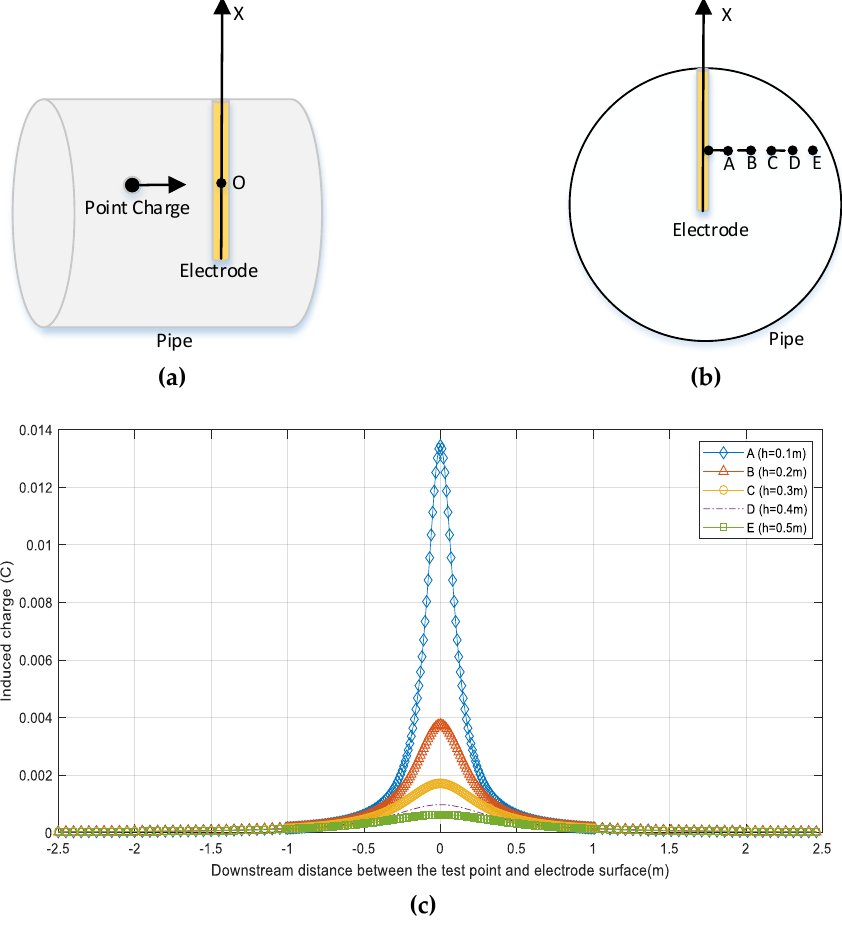
Figure 6. Locations of point charges A, B, C, D, E in the pipeline: ( a ) Point charge moving in the pipeline; ( b ) point charge distance from the electrode; and ( c ) induced charge of the point charge moving perpendicular to the electrode’s axis .